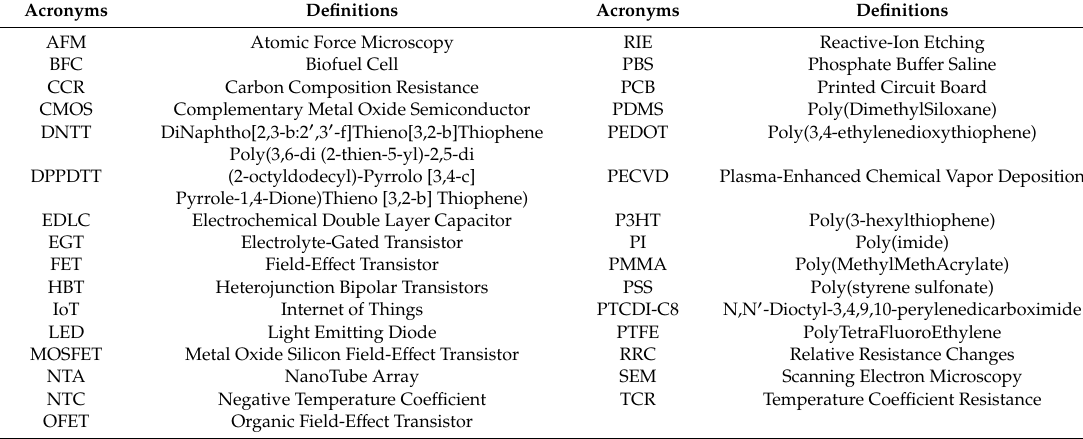
Table 1. Glossary of acronyms used in this review, sorted by alphabetical